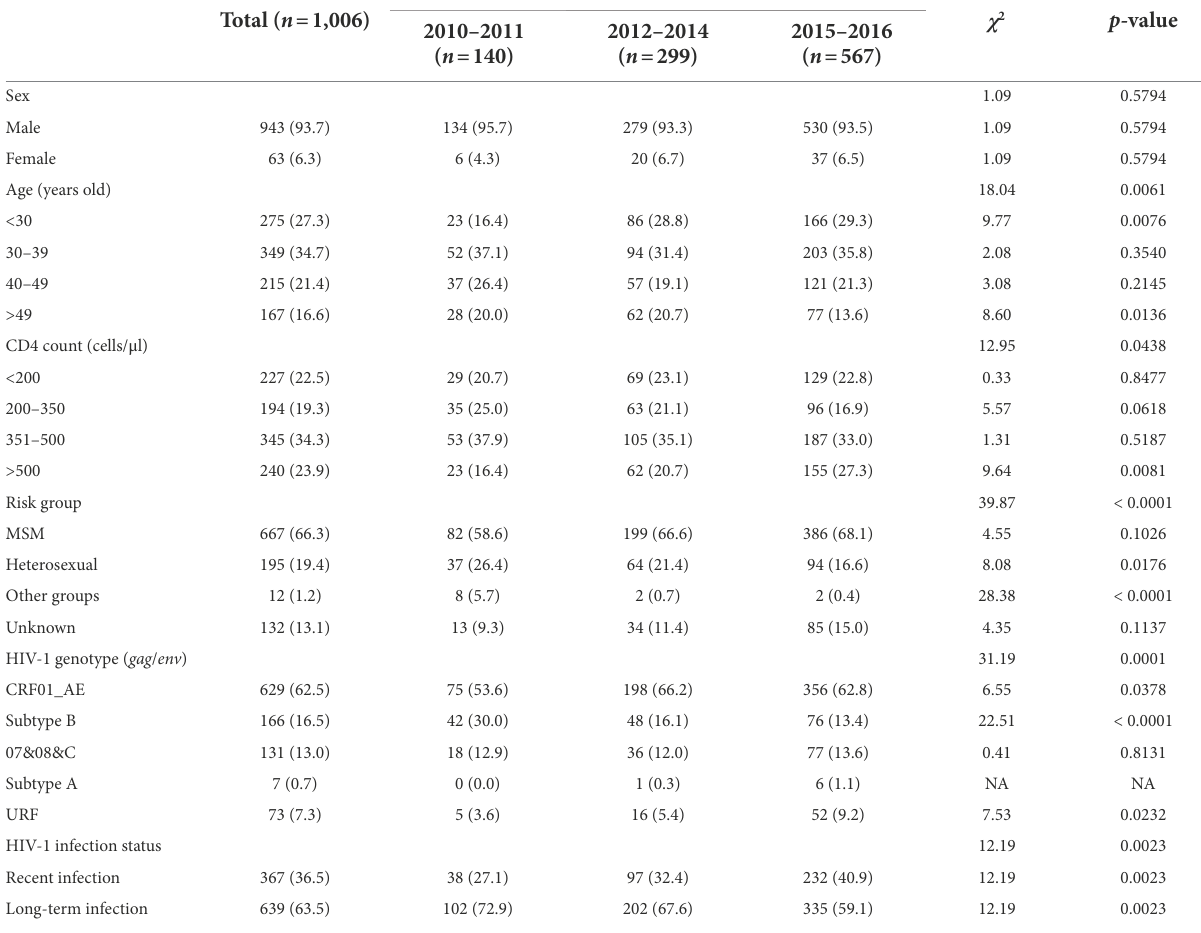
TABLE 1 Basic information of the participants in this